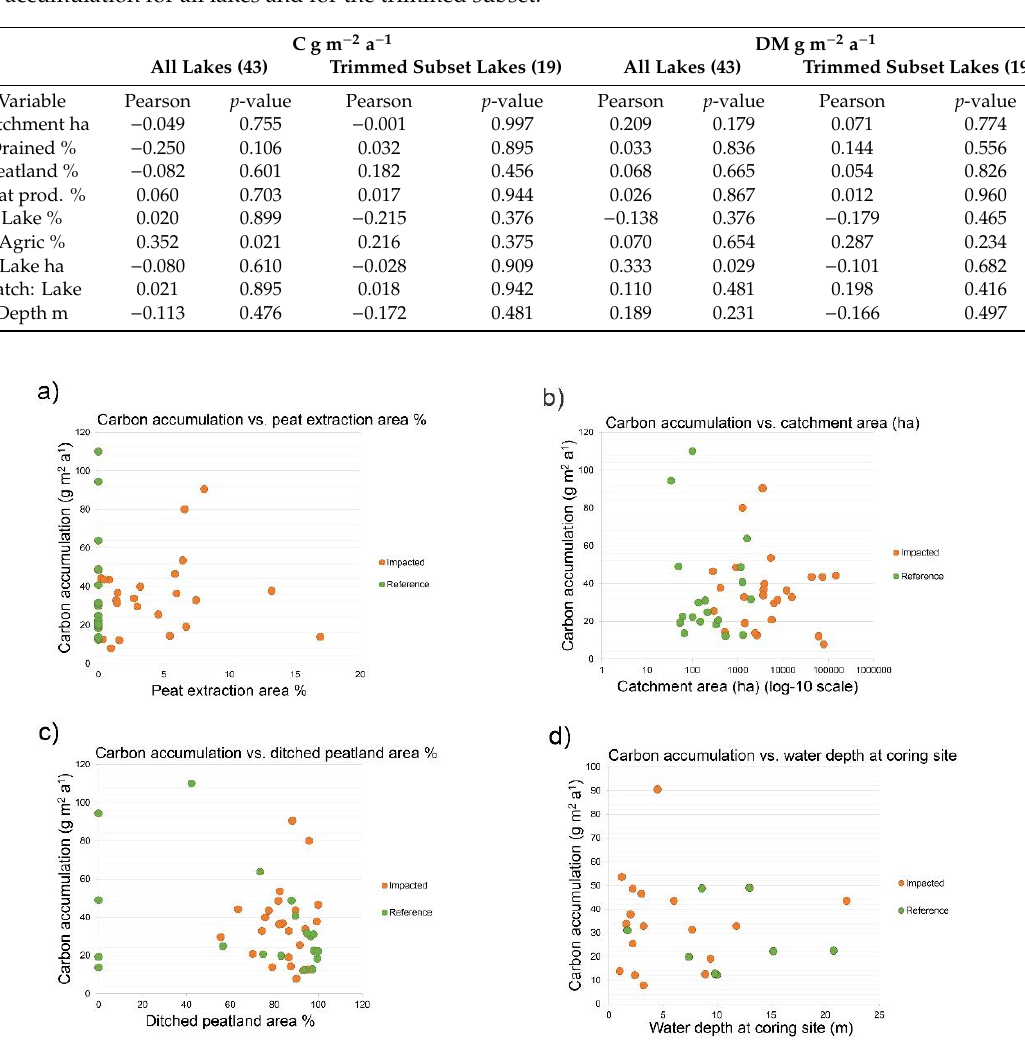
Table 3. Linear (Pearson) correlations of environmental variables with carbon and dry matter accumulation for all lakes and for the trimmed subset.